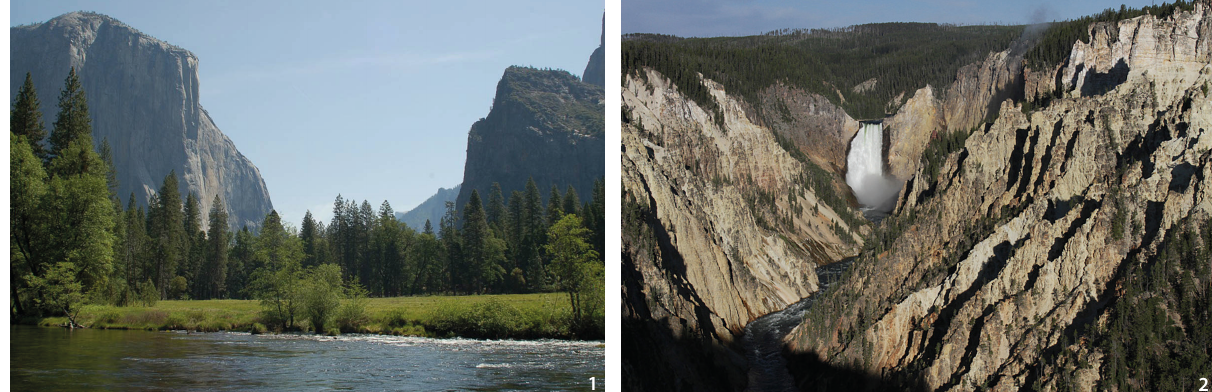
Figure 1 Merced River and Yosemite Valley, the first area set aside in 1864, Yosemite National Park (Source: National Park Service). Figure 2 The scenic Lower Yellowstone Falls in Yellowstone National Park (Source: National Park Service).